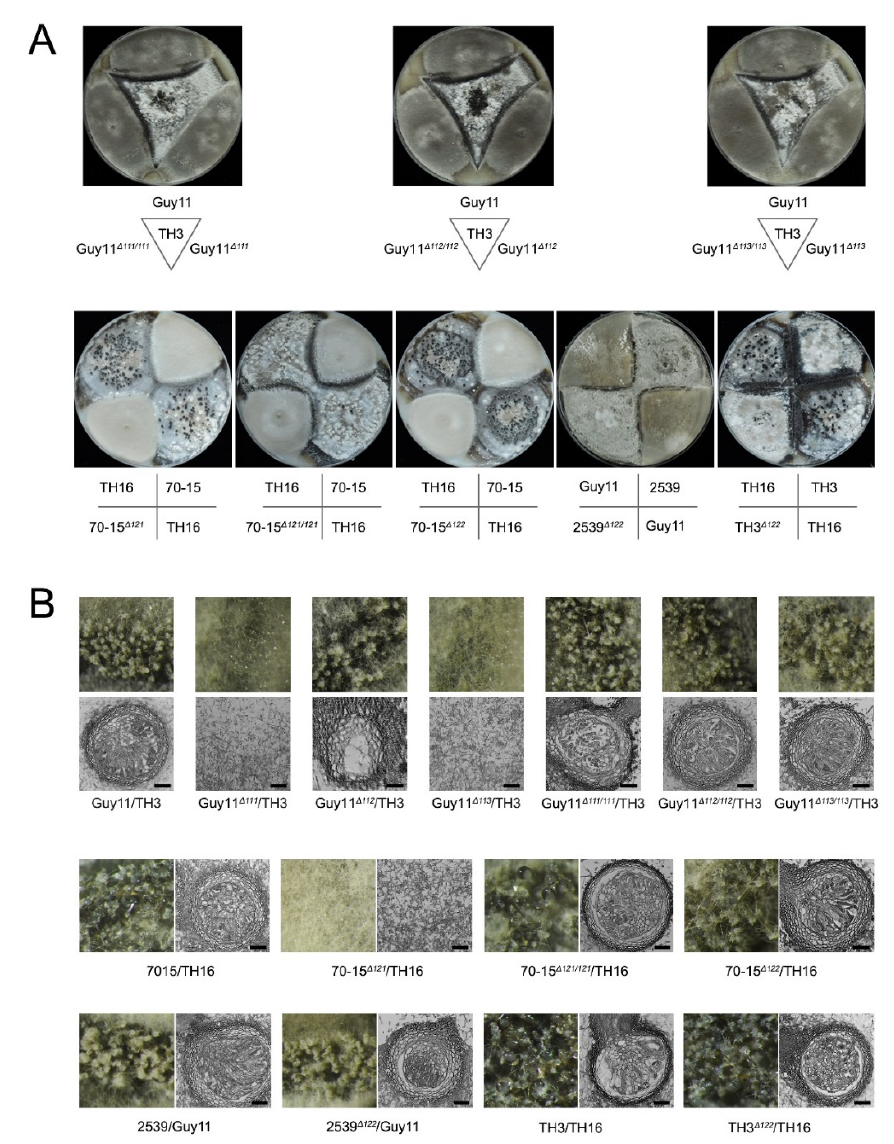
Figure 4. Function of individual MAT genes in sexual reproduction. ( A ) Crossing experiments of the wild-type strains, mutants and recovery transformants on OMA plates; ( B ) the perithecia generated in different combinations were observed in 60 × magnification under a stereomicroscope, and the inner structures were observed via paraffin section method. Bars = 20 μ m.